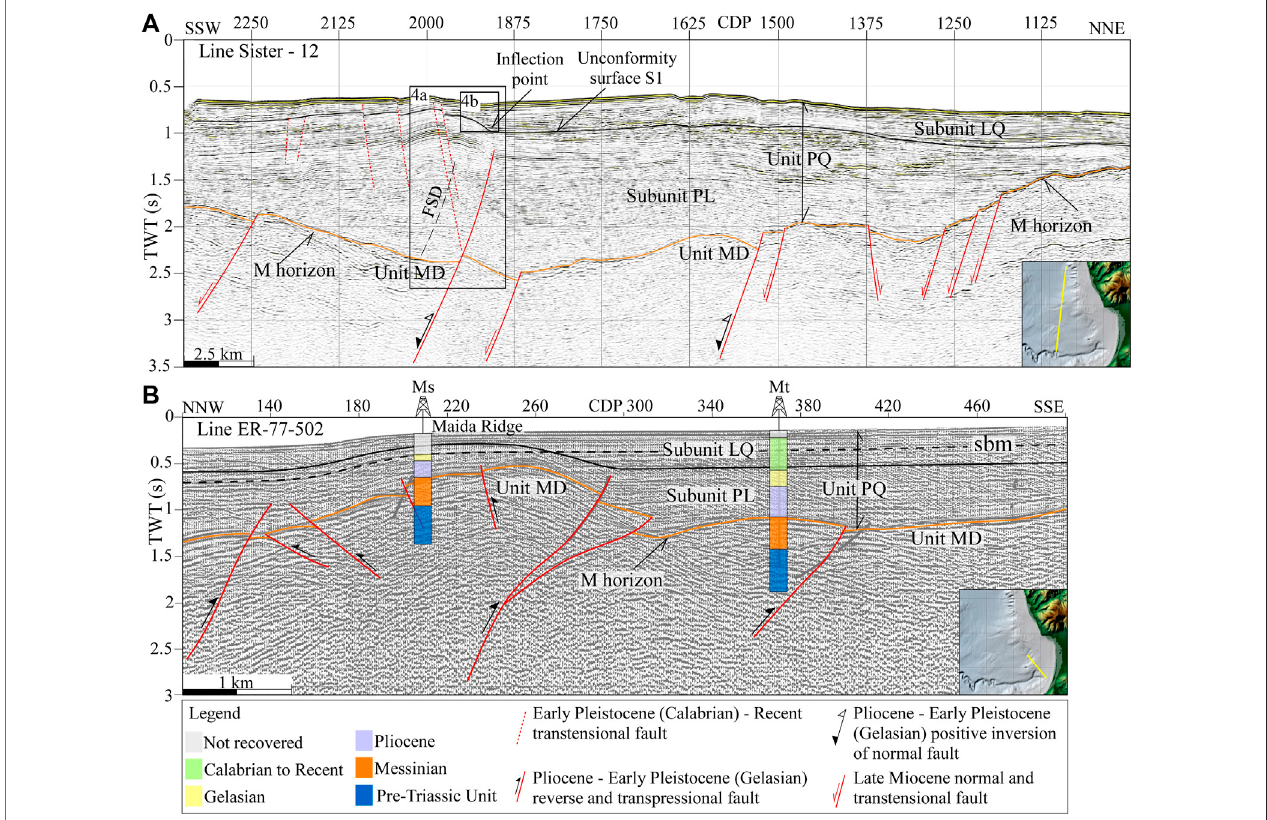
FIGURE 5 | (A) Seismic pro fi le “ Line Sister — 12 ” and its interpretation. Boxes 4a and 4b are displayed in Figure 4 . (B) Seismic pro fi le “ Line ER-77-502 ” and its interpretation. Insets show the location of the pro fi les. Ms, Marisa well; Mr, Marta well; FSD, fan-shaped deposits; sbm., seabed multiple; Unit MD, Upper Miocene deposits; Unit PQ, Plio Quaternary deposits; PL and LQ, subunits of the Plio Quaternary